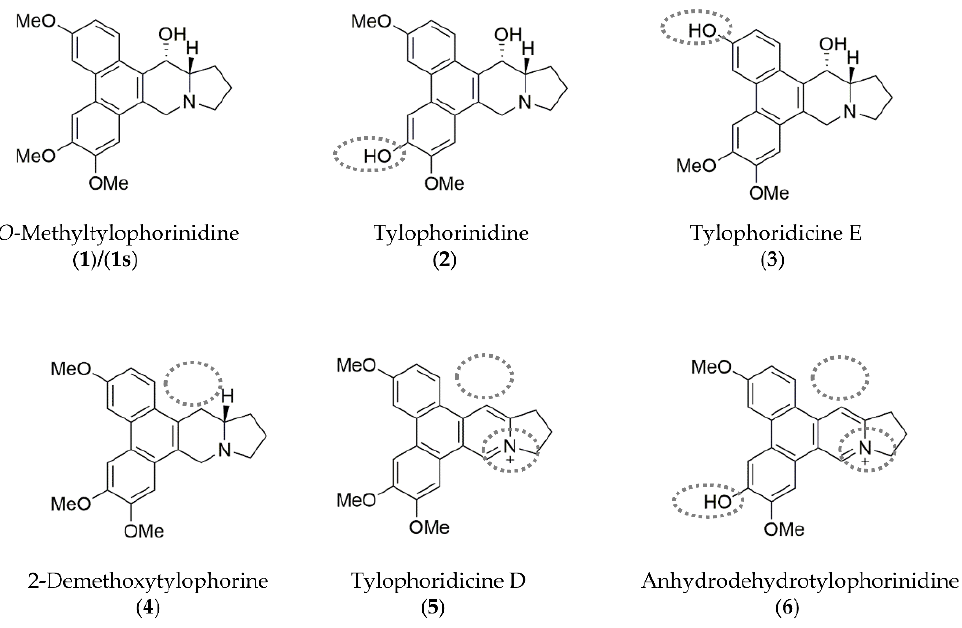
Figure 1. Chemical structures of the phenanthroindolizidine alkaloids (PAs) compound ( 1 )/( 1s ) and its naturally occurring derivatives (compounds ( 2 )–( 6 )) are shown with their distinct character- istics highlighted (grey dotted lines) compared to compound ( 1 ). Illustrations were drawn using ChemDraw (PerkinElmer Informatics, Hamburg, Germany; Version: